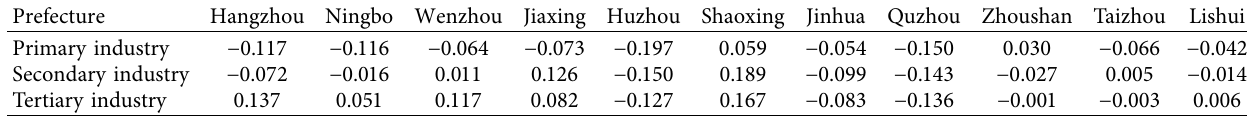
Table 3: Normalized weighting matrix.